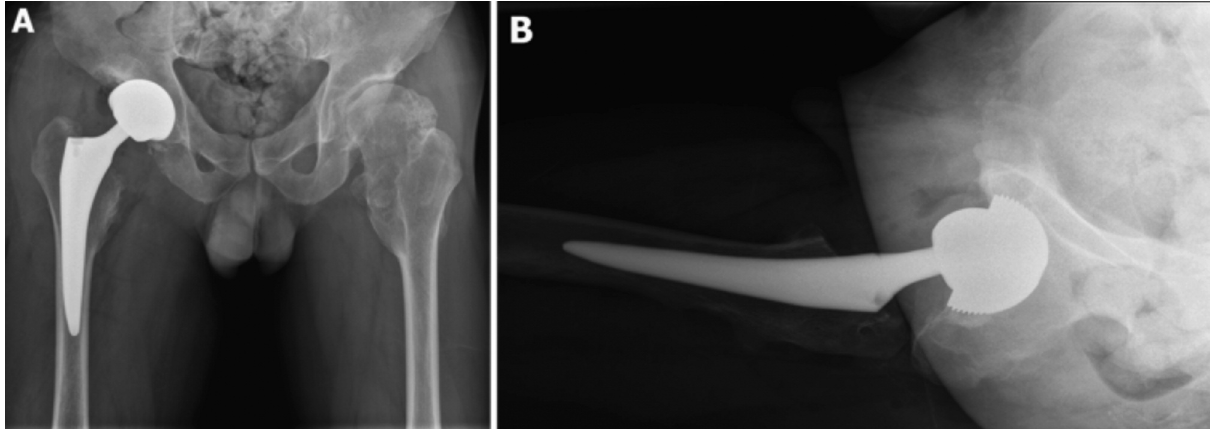
(a) Postoperative anteroposterior pelvic radiograph showing no limb length discrepancy. (b) The right lateral hip radiograph Fig. 3: showing proper acetabular component